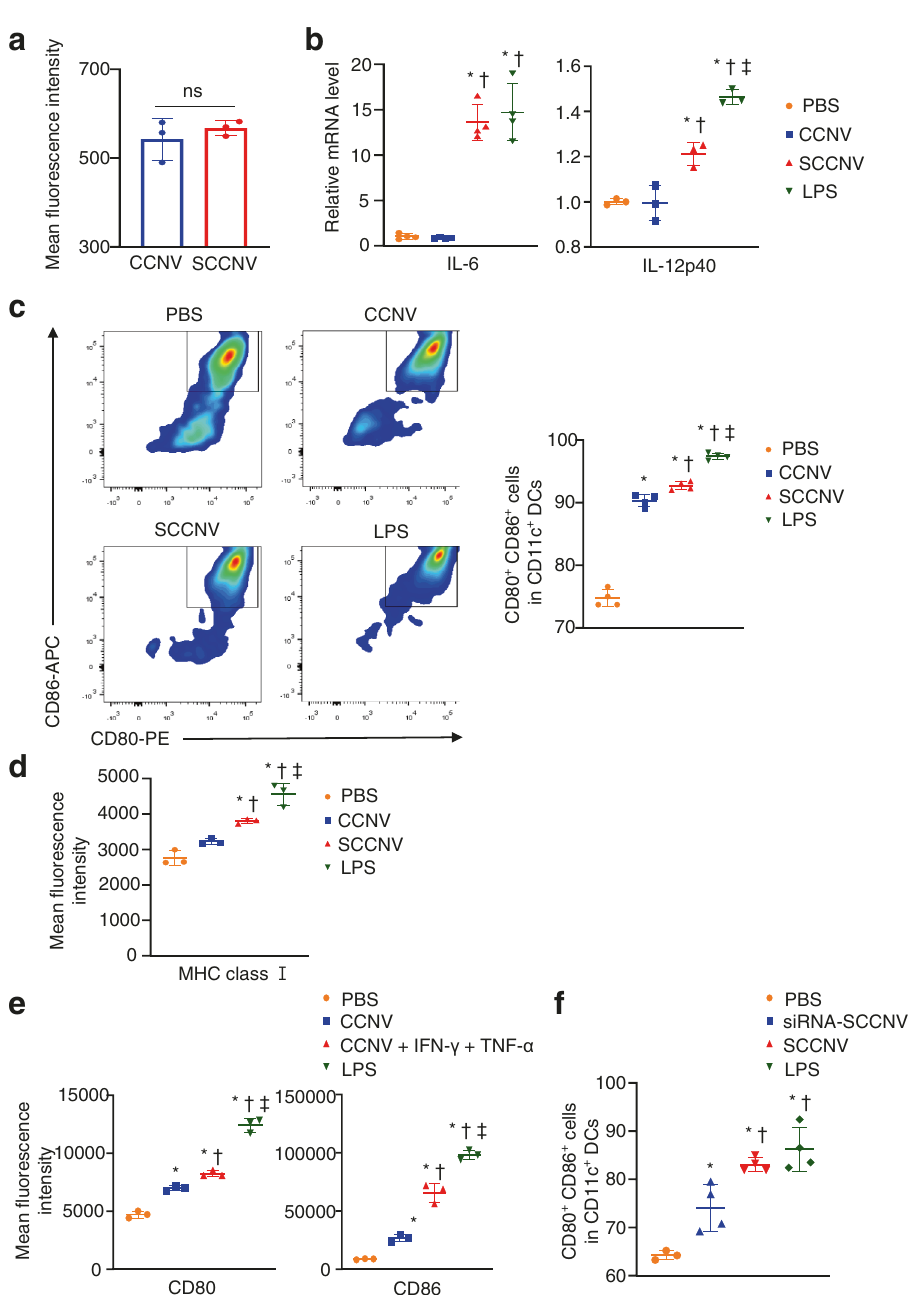
Fig. 3 Effective DC maturation in vitro by SCCNVs. a In vitro uptake of CCNVs and SCCNVs by DCs for 10 min, as evaluated by fl ow cytometric analysis. n = 3. b mRNA levels of DC maturation markers (IL-6 and IL-12p40) in BMDCs treated with PBS, CCNV, SCCNV, or LPS for 4 h in vitro, as evaluated by qRT ‒ PCR. n = 3-4. c Representative fl ow cytometry plot and percentage of CD80 and CD86 double-positive cells in BMDCs treated with PBS, CCNV, SCCNV, or LPS for 24 h in vitro, evaluated by fl ow cytometric analysis. n = 4. d Flow cytometric analysis of MHC class I expression of BMDCs treated with PBS, CCNVs, SCCNVs, or LPS for 24 h in vitro, as evaluated by fl ow cytometric analysis. n = 3. e Flow cytometric analysis showing that the enhanced DC maturation induced by SCCNVs is likely due to IFN- γ and TNF- α contained in SCCNVs. Exogenous IFN- γ and TNF- α were added to the CCNV + IFN- γ + TNF- α group. n = 4. f Effects of various treatments for 24 h on DC maturation, as evaluated by fl ow cytometric analysis. siRNA-SCCNVs are nanovesicles derived from senescent cancer cells transfected with siRNA speci fi c for IFN- γ and TNF- α . n = 4. In ( b – f ), LPS was used as the positive control. Data represent the mean ± SD. Statistical signi fi cance was calculated by Student ’ s t -tests or one-way ANOVA with Tukey ’ s multiple comparisons test. * P < 0.05 versus PBS; † P < 0.05 versus CCNVs; ‡ P < 0.05 versus SCCNVs in b , c , d and f and versus CCNVs + IFN- γ , TNF- α in e . ns not signi fi